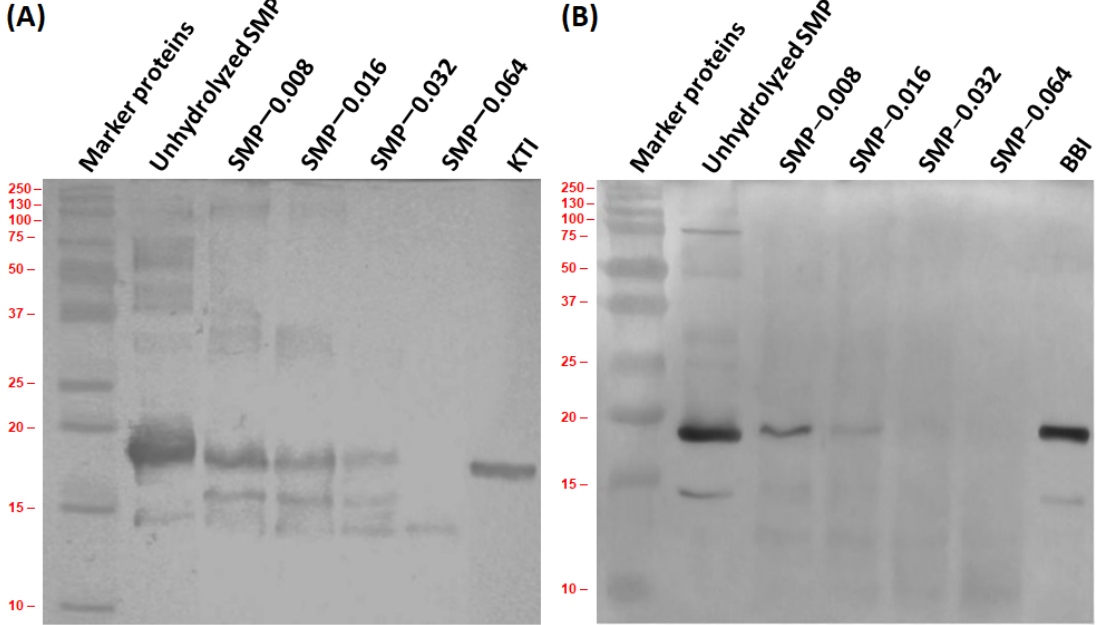
Figure 4. Immunoblot of unhydrolyzed and papain-hydrolyzed SMP with Rb polyclonal antibodies: KTI ( A ) and BBI ( B ).